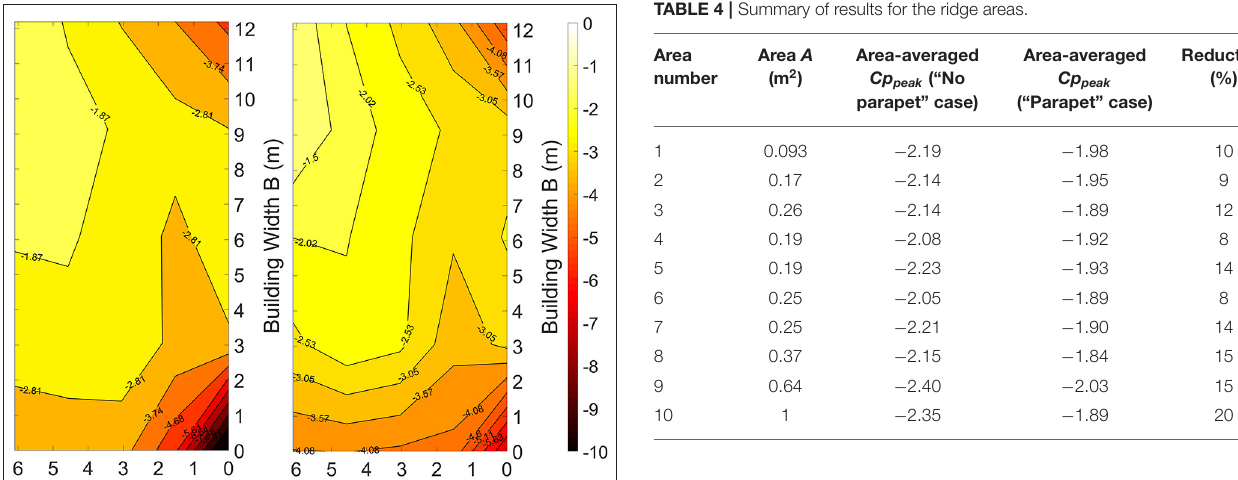
TABLE 5 | Comparisons of current research results and those from the literature for perforated parapets.